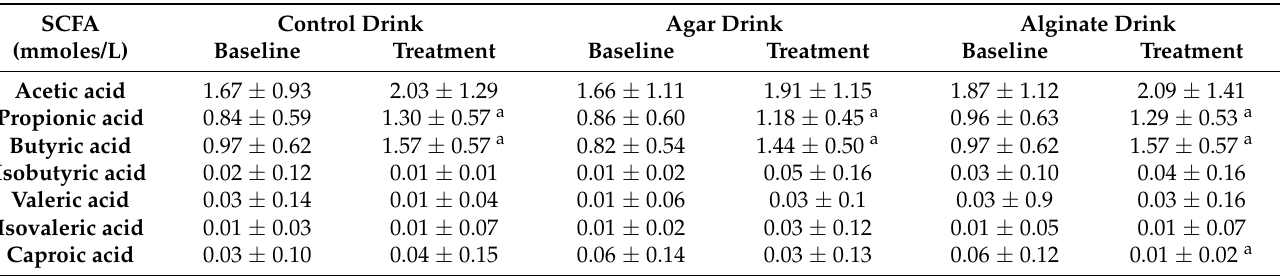
Table 5. Effects of consumption of control, agar, and alginate drink(s) on faecal short-chain fatty acid concentration.